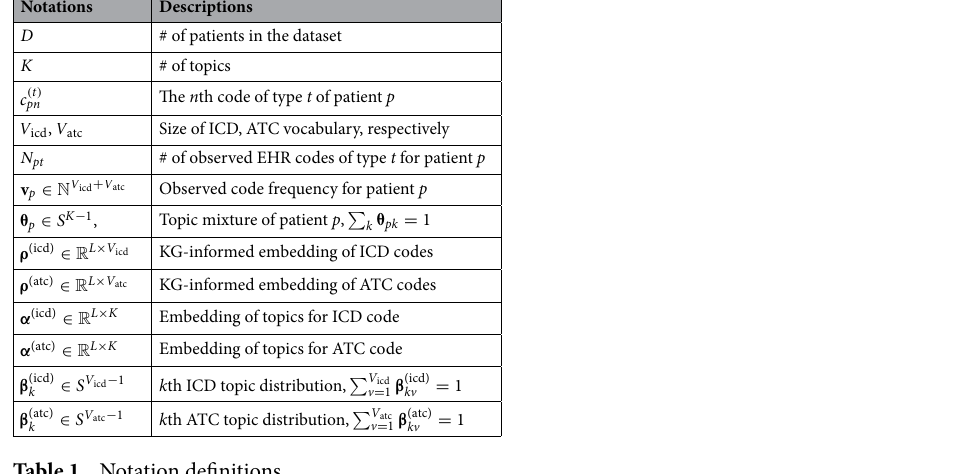
Table 1. Notation